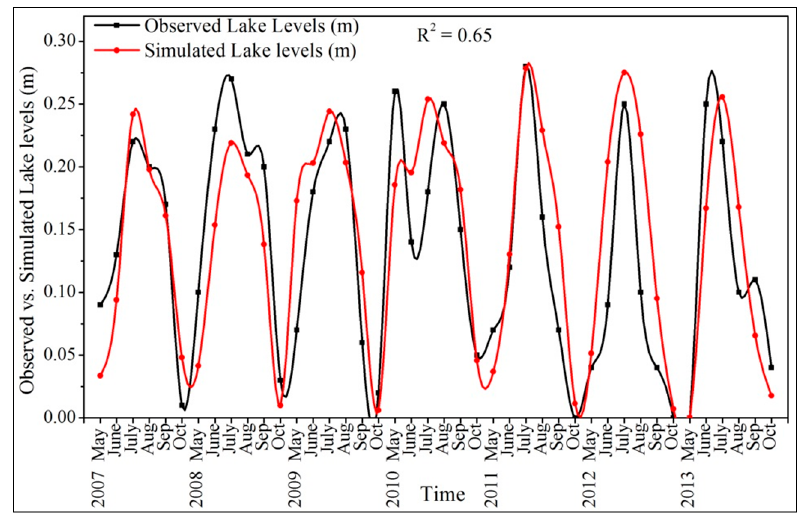
Figure 3. Validation of SWAT model simulated lake levels with the observed levels of the Nam Co Lake.